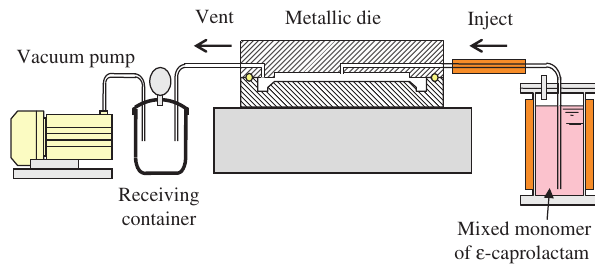
Figure 1 Schematic view of VaRTM for